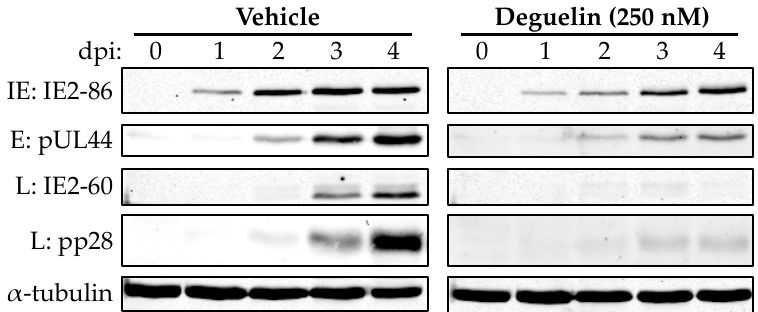
Figure 6. Deguelin treatment results in a reduction of E protein translation in HCMV infected fibroblasts. NuFF-1 cells were treated with vehicle (DMSO) or deguelin (250 nM) for 1 h, after which cultures were infected with UL99 eGFP (moi = 1.0). Total cell lysates were collected over 4 d and viral protein expression was assessed by immunoblot for the following proteins: IE2-86 (IE), pUL44 (E), pp28 (L), and IE2-60 (L). Tubulin is shown as a loading control. Data is from a representative experiment ( n = 3).